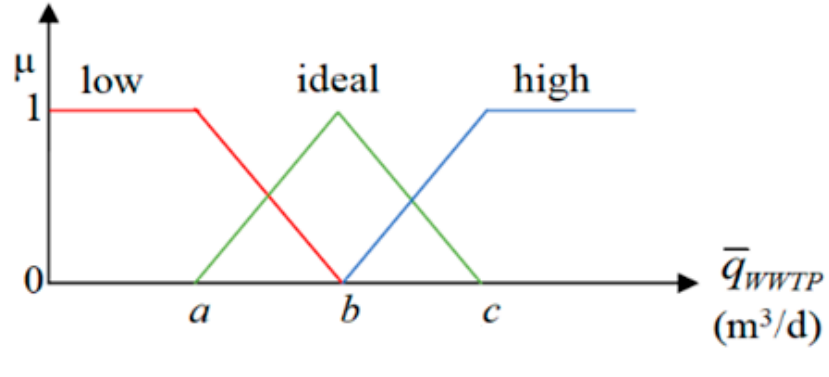
Figure 7. Fuzzy sets for q